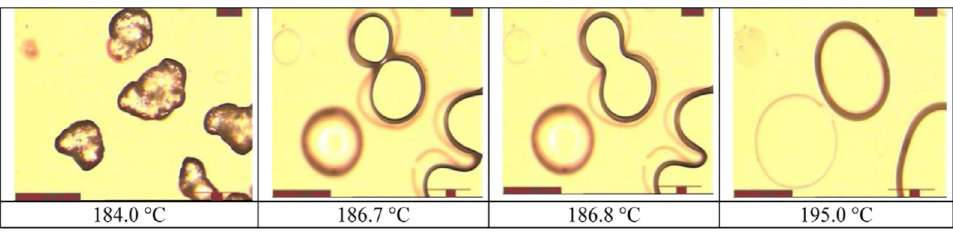
Figure 14. Evaluation of coalescence of PA12 particles using hot stage microscopy [97].